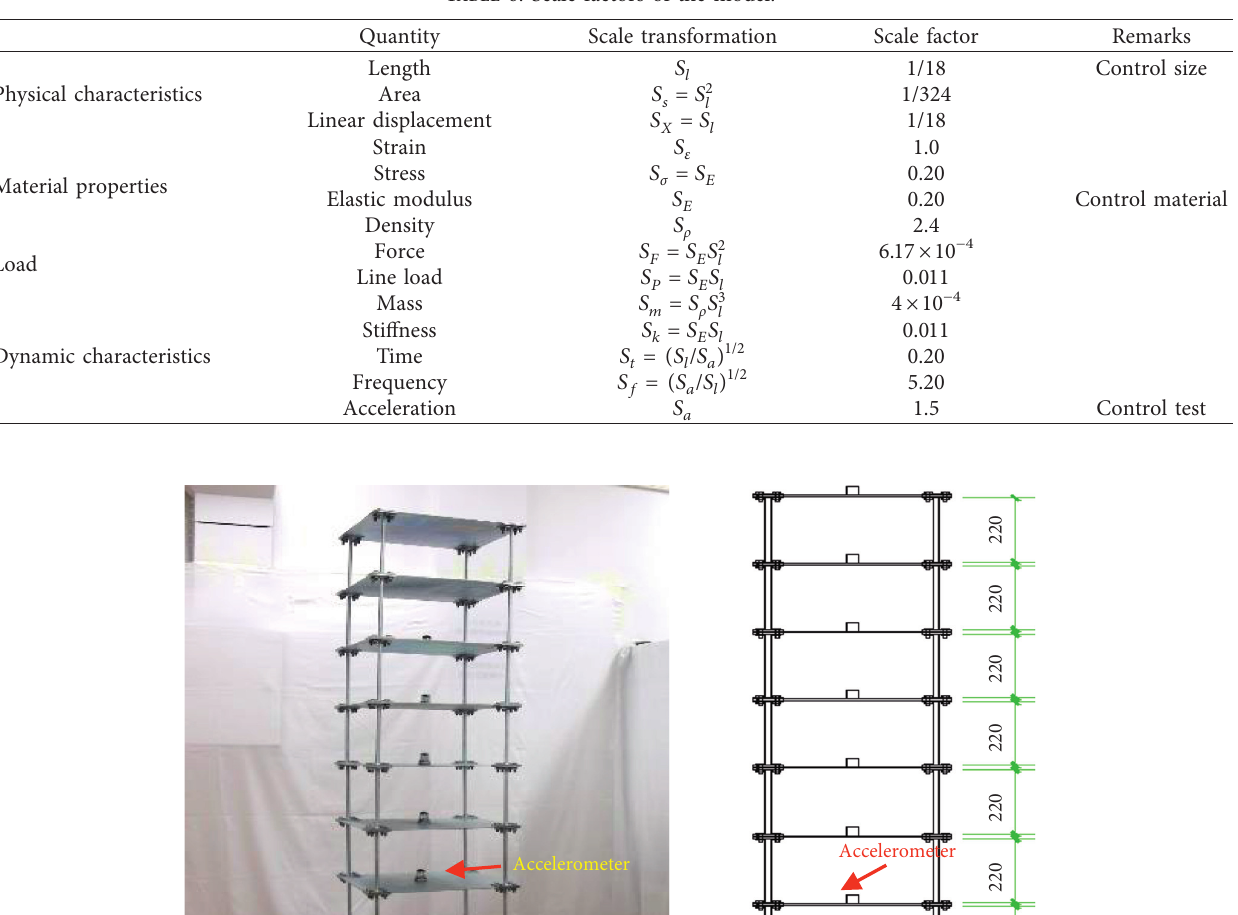
Table 6: Scale factors of the model.